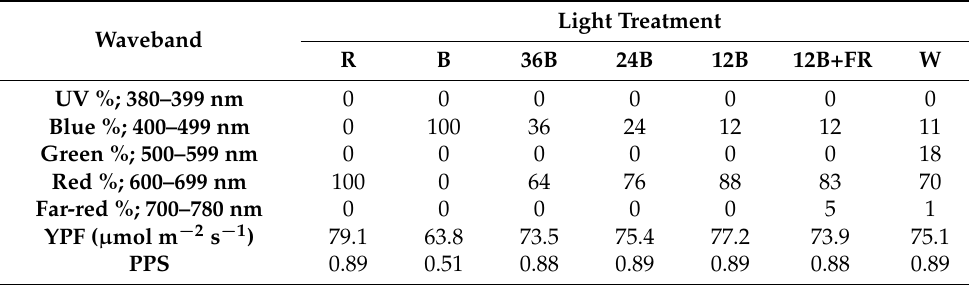
Table 1. Spectral distribution, yield photon flux (YPF), and phytochrome photostationary state (PPS) for the light treatments tested. Values are percentages of total photons reaching the seedling canopy. Light Treatment Waveband